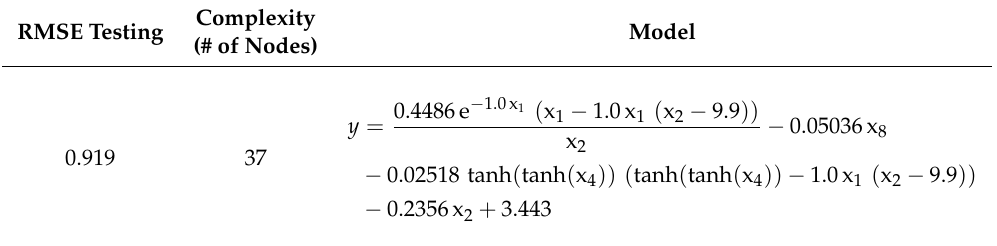
Table 9. i th Best model in the Pareto front, from the stand point of accuracy and complexity (1–4 scale) (GPTIPS).